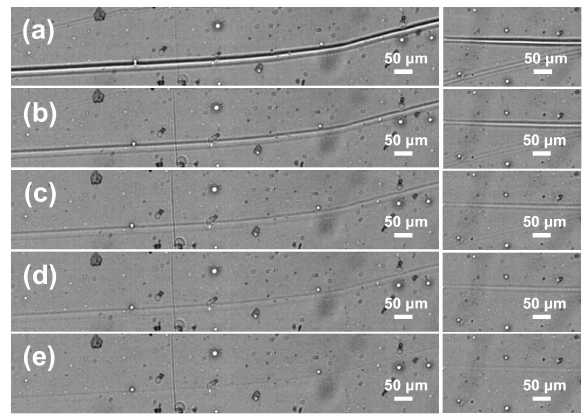
Figure 9. Scratch-healing of the crosslinked PETMP-TTT polymer network: ( a ) initial scratches obtained after brushing; ( b ), ( c ), ( d ), and ( e ) images of the scratches after 10 min, 30 min, 50 min, and 110 min at room temperature, respectively.